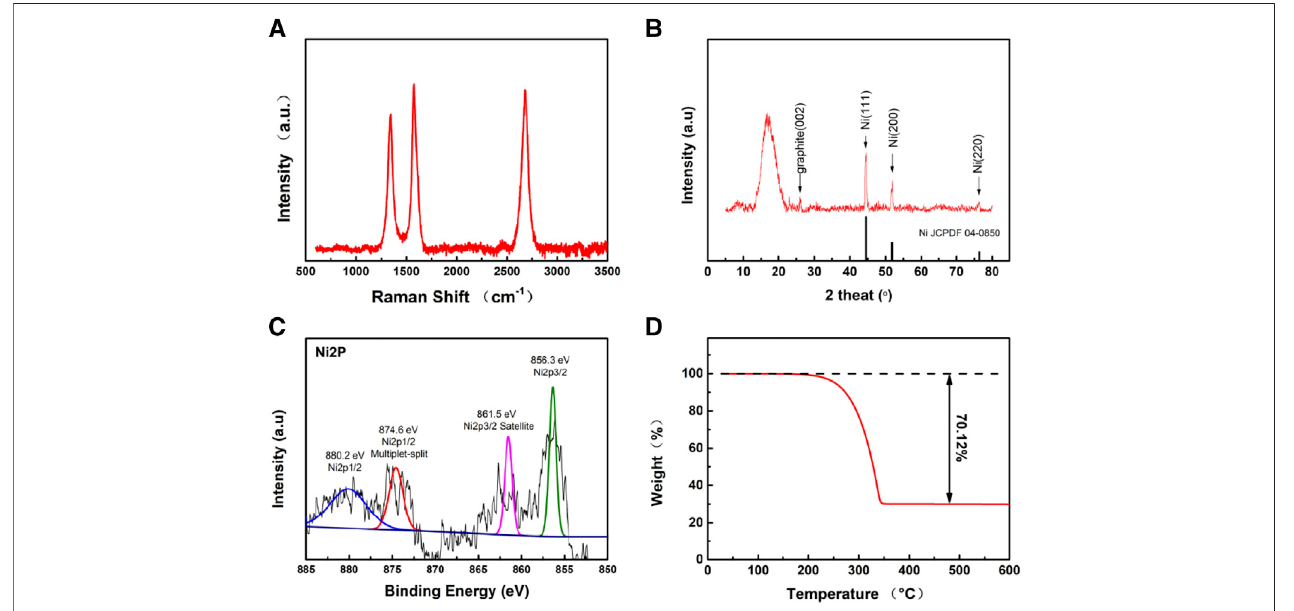
FIGURE 3 | (A) Raman spectra of HCF. (B) XRD spectra of Ni@HCF. (C) Ni 2P XPS spectrum of Ni@HCF. (D) TGA curves of Ni@HCF/S in N 2 .